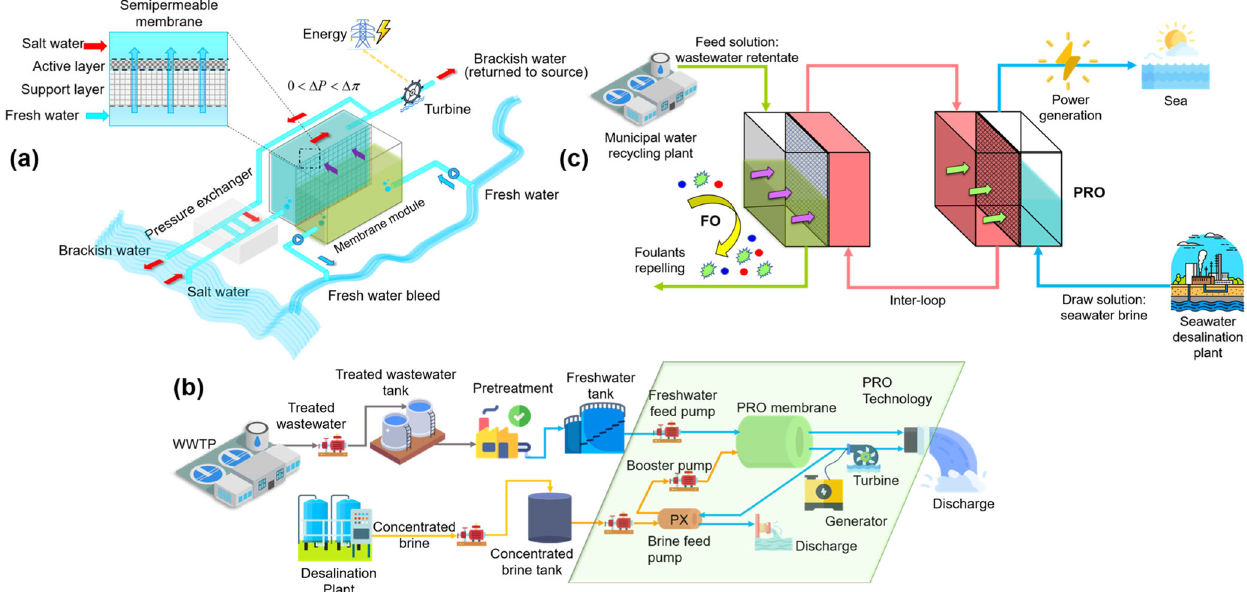
Fig. 2 Salinity gradient energy (SGE) recovery processes. a Schematic diagram of a pressure retarded osmosis plant run on river water vs. seawater [adapted from ref. 28 ], b A demonstration conducted by Kyowakiden Industry Co., Ltd., used a mixed discharge system of treated sewage from Wajiro Wastewater Treatment Center and brine from Fukuoka Seawater Desalination Center, Japan, to feed into pressure retarded osmosis system and harvest power of 10 W m − 2 [adapted from ref. 32 ], and c forward osmosis-pressure retarded osmosis hybrid system to mitigate membrane fouling for sustainable salinity gradient energy [adapted from ref. 167 ]. Credit: www. fl aticon.com for the cliparts.